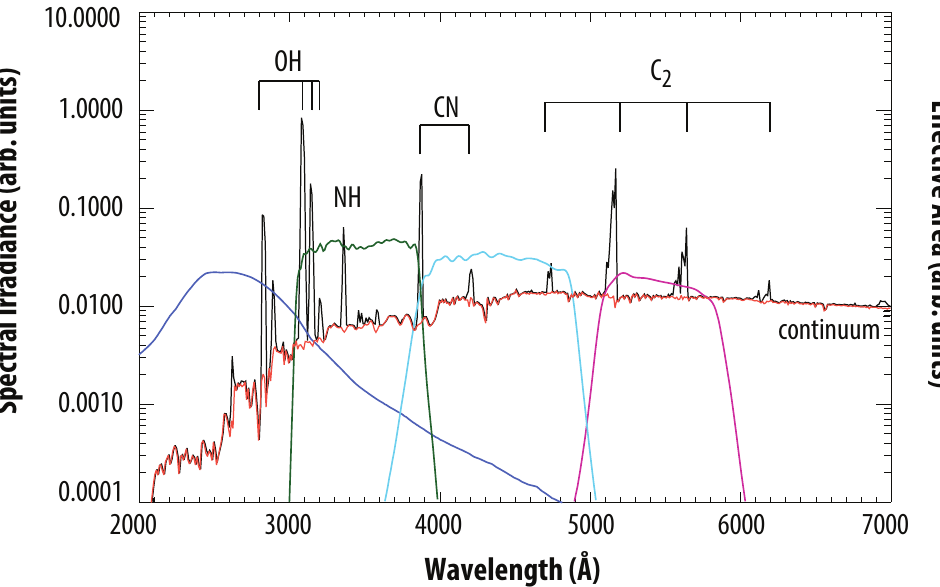
Figure 1. Model spectrum of a typical comet generated with the Planetary Spectrum Generator [18]. At near-ultraviolet/optical wavelengths, the cometary spectrum consists of a continuum, caused by sunlight reflected by dust surrounding the nucleus (red), superimposed by the emission features of various radical species, such as OH, CN, and C 2 . Overlaid are the bandpasses of some of UVOT’s filters: UVW1 (blue); U (green); B (cyan); and V